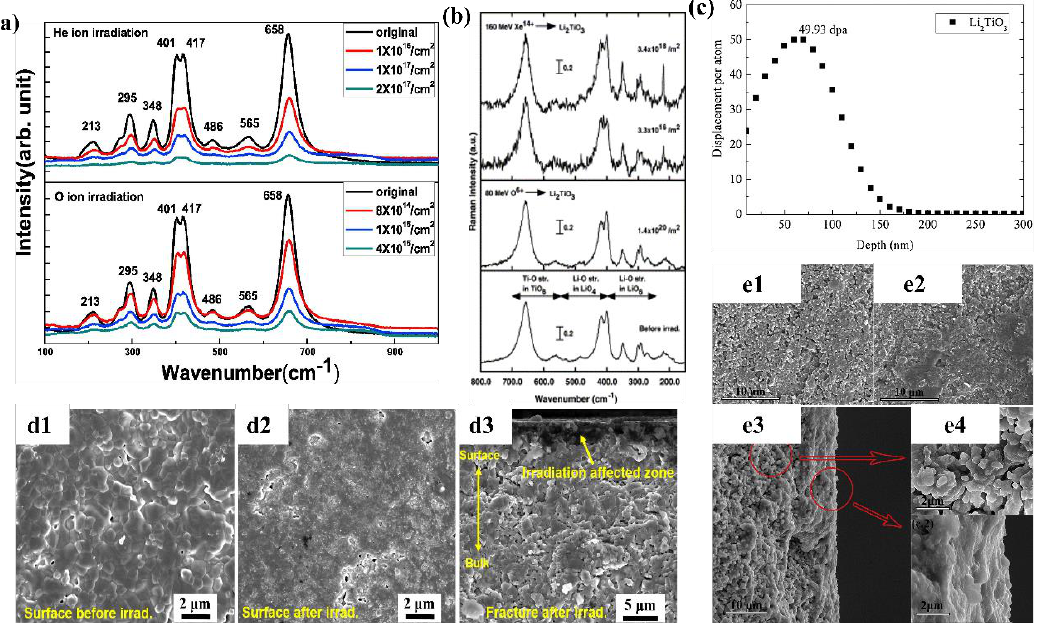
Figure 10. ( a ) Raman spectrum changes of Li 2 TiO 3 irradiated by helium and oxygen ions. Reprinted with permission from ref. [22]. ( b ) Raman spectra of Li 2 TiO 3 irradiated with the 80 MeV O and 160 MeV Xe ions, and of Li 2 TiO 3 before irradiation. Reprinted with permission from ref. [109]. ( c ) SRIM estimation of displacement per atom (dpa) for Li 2 TiO 3 under 150 keV Ar + irradiation. SEM images of the Li 2 TiO 3 ceramic surface before irradiation ( d1 ) and after irradiation ( d2 ), and ceramic fracture after irradiation ( d3 ). Reprinted with permission from ref. [110]. SEM images of the composite ce- ramic before and after irradiation: ( e1 ) surface of the ceramic before irradiation; ( e2 ) surface of the ceramic after irradiation; ( e3 ) fracture of the ceramic after irradiation; (e4) partial enlargement of fracture of the ceramic after irradiation. Reprinted with permission from ref. [111].